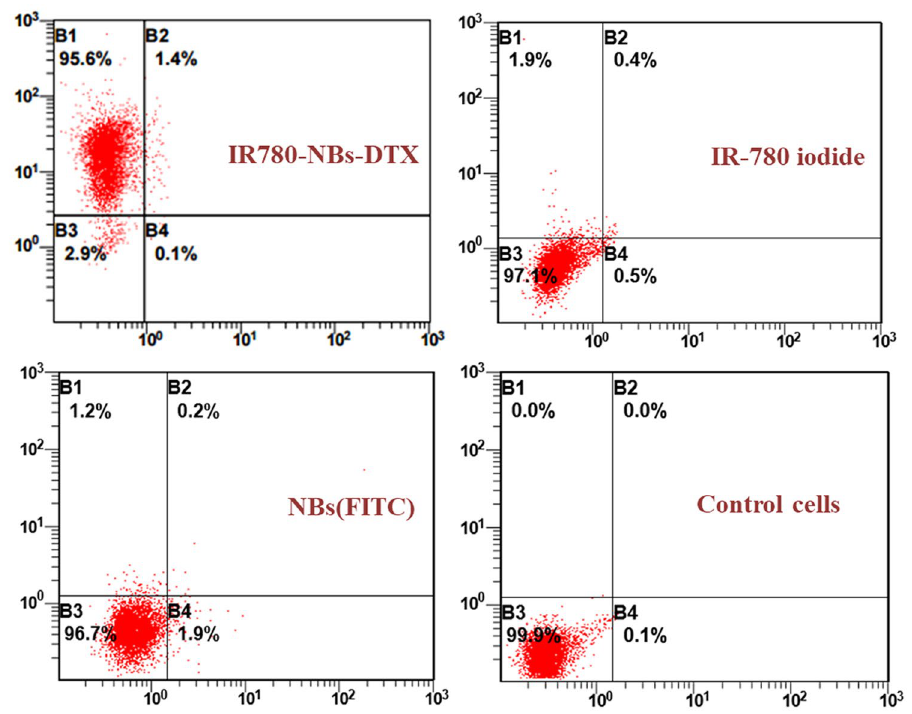
Figure 7. Tumor-targeting rates of IR780-NBs-DTX, IR-780 iodide and NBs(FITC) evaluated via FCM analysis after incubation with Mia-Paca2 pancreatic cancer